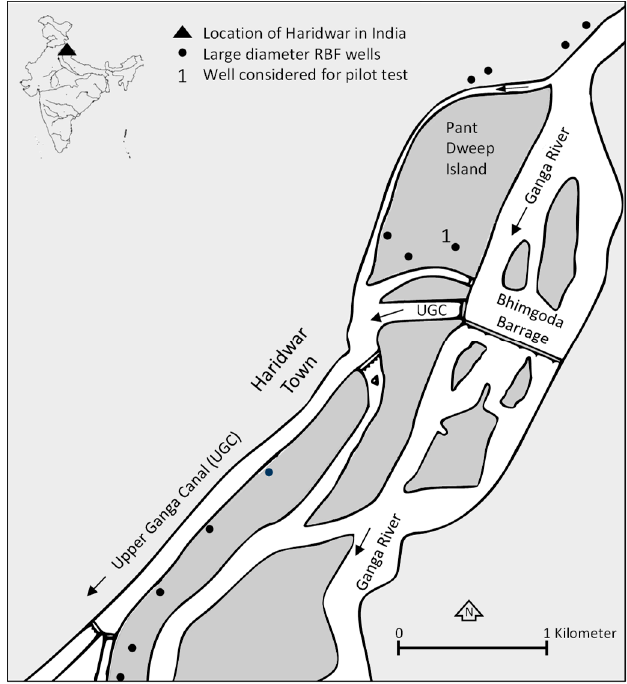
Figure 1. Location of the large diameter well on Pant Dweep Island at Haridwar (after [12]).